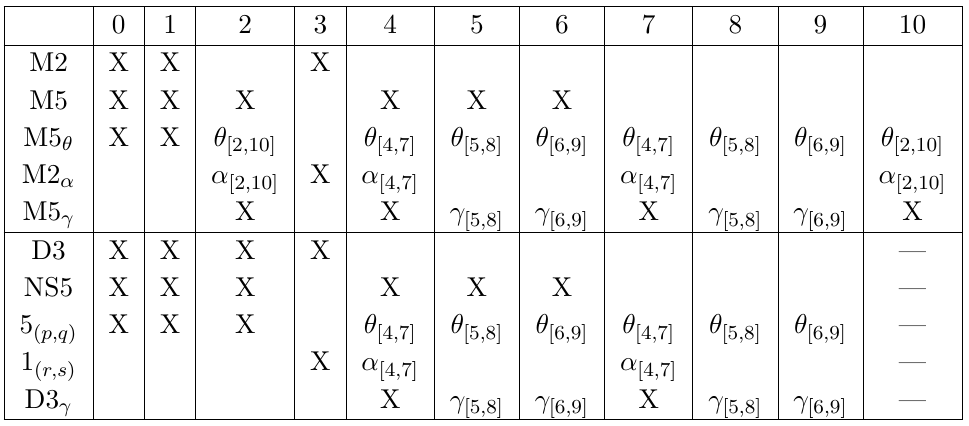
Table 4 . M-theory brane array and dual IIB brane array realizing chiral operator insertions in 3d N = 3 theories. Here tan (cid:18) = q=p , tan (cid:11) = s=r and (cid:13) is